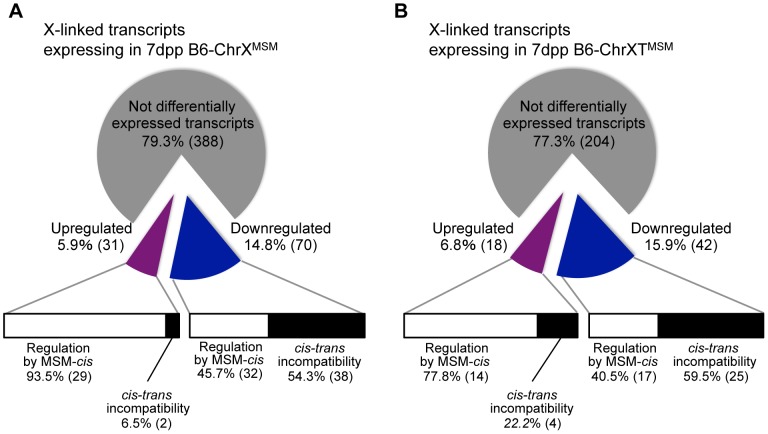
Classification of MSM-derived X-linked transcripts in B6-ChrXMSM and B6-ChrXTMSM.Pie charts depict the frequency of upregulated (purple) and downregulated (blue) transcripts in B6-ChrXMSM (A) and B6-ChrXTMSM (B) testes relative to B6 expression at 7 dpp. Horizontal bars depict the proportion for each type of transcriptional regulation; differential expression by MSM-derived cis-regulatory elements (white bar) and misregulation caused by the genetic incompatibility between cis-regulatory elements and trans-acting factors (black bar).